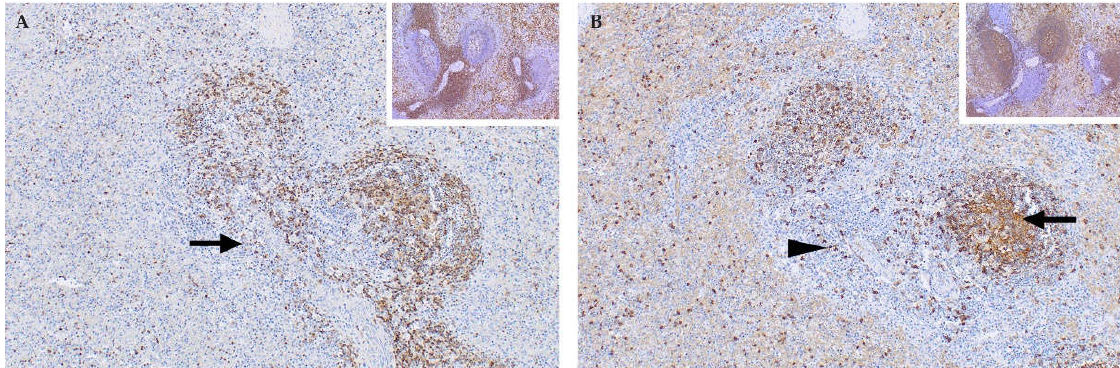
Figure 9. Spleen of an RVFV-infected adult sheep with sequential sections immunolabelled for T and B lymphocytes respectively (polyclonal rabbit anti-CD3 and anti-CD20 antibodies, micro-polymer detection system, DAB chromogen and haematoxylin counterstain). ( A ) Labelling with the anti-CD3 antibody shows a marked loss of T lymphocytes. Only scattered T lymphocytes remain in the red pulp and there is severe depletion of the periarteriolar lymph sheath (arrow), mag 100×. Inset: Spleen from a healthy control sheep showing a normal distribution of abundant T lymphocytes, mag 100×. ( B ) Labelling with the anti-CD 20 antibody shows necrotic debris in the germinal centre (arrow) with a few residual B lymphocytes in the marginal zones (arrowhead) of the periarteriolar lymph sheath and in the red pulp, mag 100×. Inset: Spleen from a healthy sheep with multiple lymphoid follicles that contain many B lymphocytes, mag 100×.